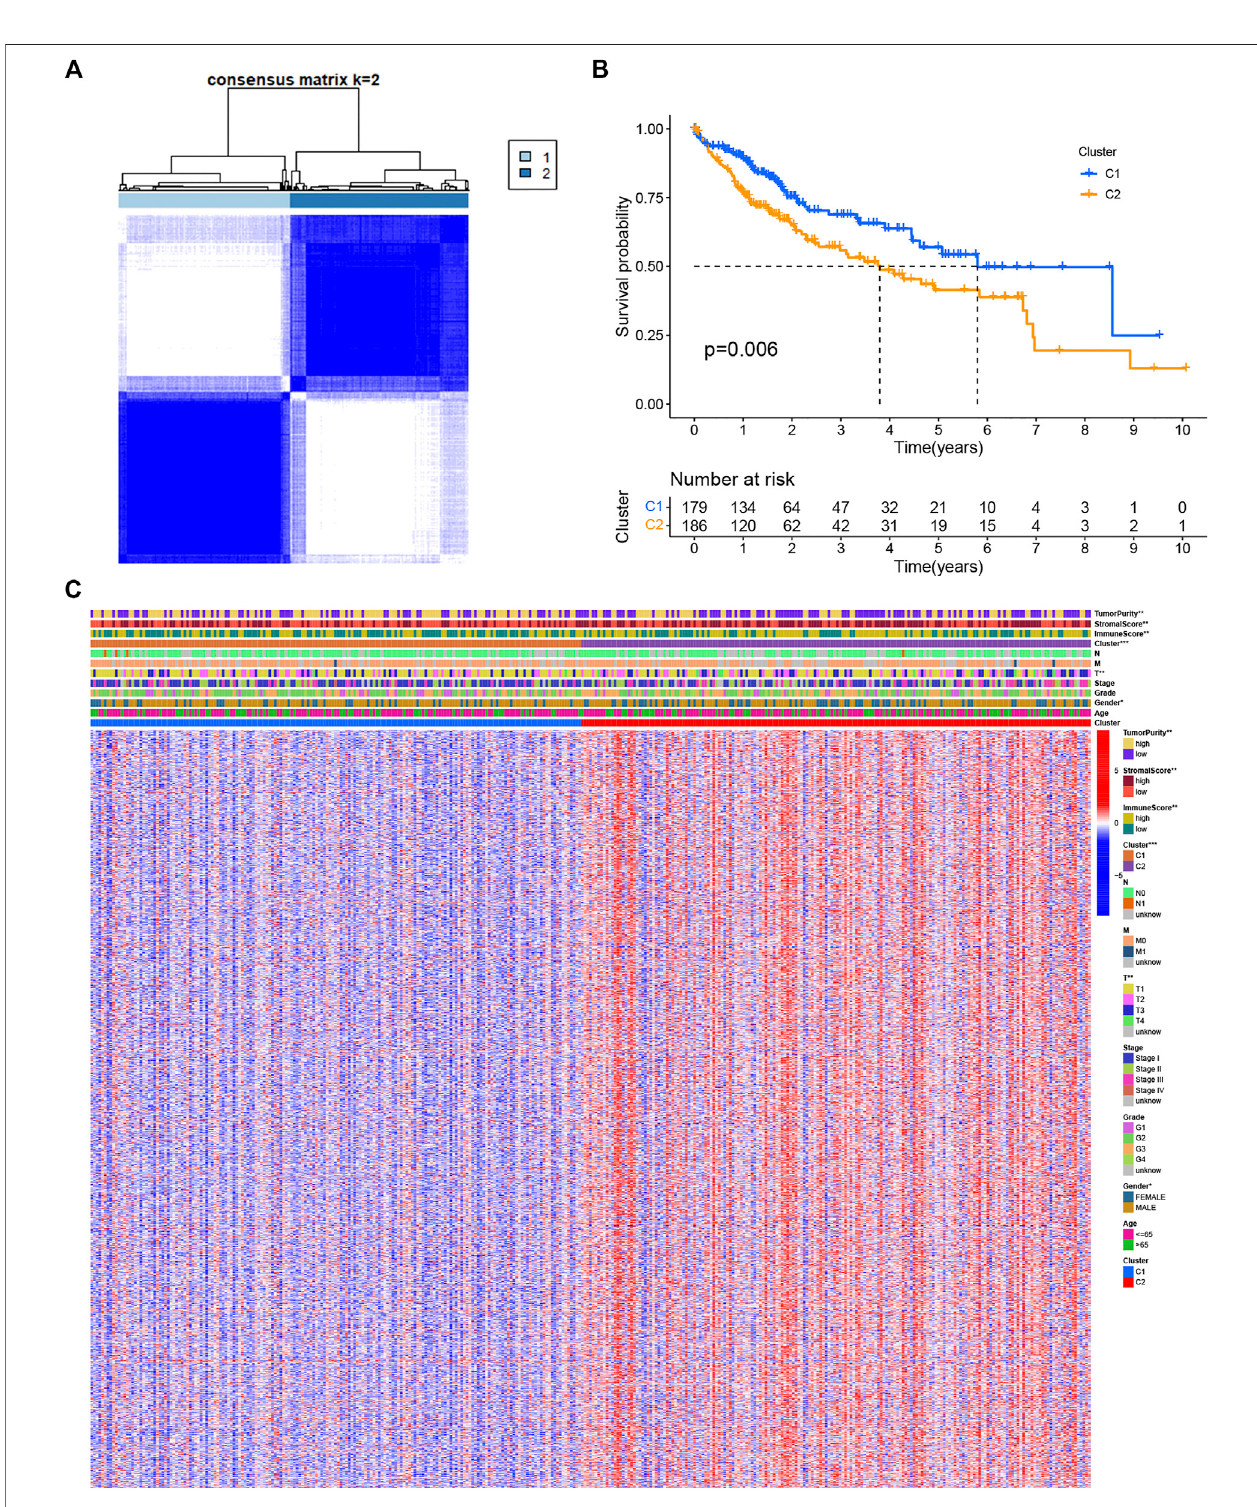
FIGURE2| Clustersbased on theexpression ofnecroptotic regulators inLIHC. (A) Consensus matrix heatmap ofLIHCpatientswhen k =2. (B) OScurves for the two clusters showing the association between necroptosis regulator-based clusters and OS. (C) Consensus clustering of clinical variables, immune status, and differentially expressed genes between the two necroptosis-related clusters. * p < 0.05, ** p < 0.01, and *** p < 0.001.